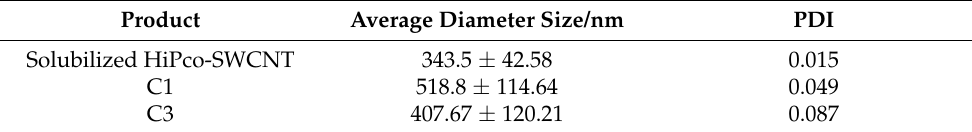
Figure 6. SEM images of HiPco-SWCNT: ( left ) to ( right ) solubilized HiPco-SWCNTs, solubilized HiPco-SWCNT attached to siRNA and MTX (C1), solubilized HiPco-SWCNT attached to scRNA and MTX (C3). Table 4. Average size diameter and PDI of the HiPco-SWCNTs (obtained from SEM).